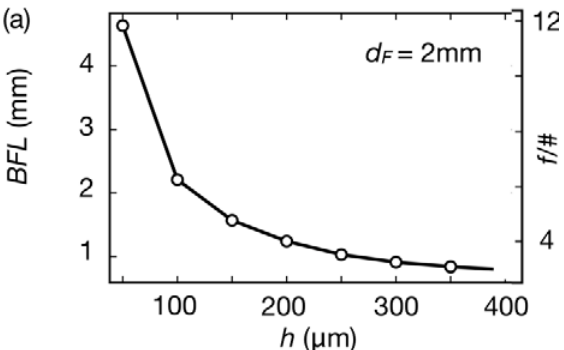
Figure 2. ( a ) Calculated back focal length ( BFL ) and aperture (f/#) vs. lens thickness along the optical axis ( h ); ( b ) Calculated spot diagram for λ = 560 nm and 2° angle for h = 100 μ m and 400 μ m; ( c ) RMS spot diameter in mm vs. wavelength for h = 100 μ m in black solid lines and h = 400 μ m in red solid lines. The diffraction-limited Airy diameter is indicated in dashed lines for the same two